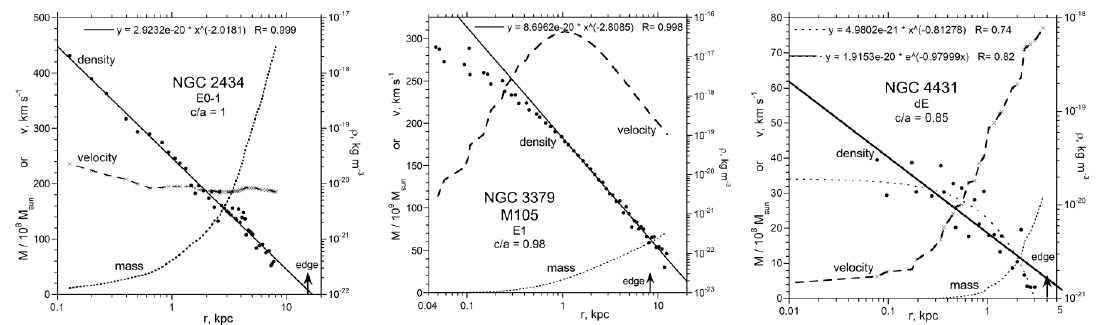
Figure A10. Elliptical galaxies. RCs of nearly spherical NGC 2434 from Rix et al. [68]. RCs of dwarf NGC 4431 from Toluba et al. [79]. RCs of NCG 3379 from Romanowsky et al. [31].